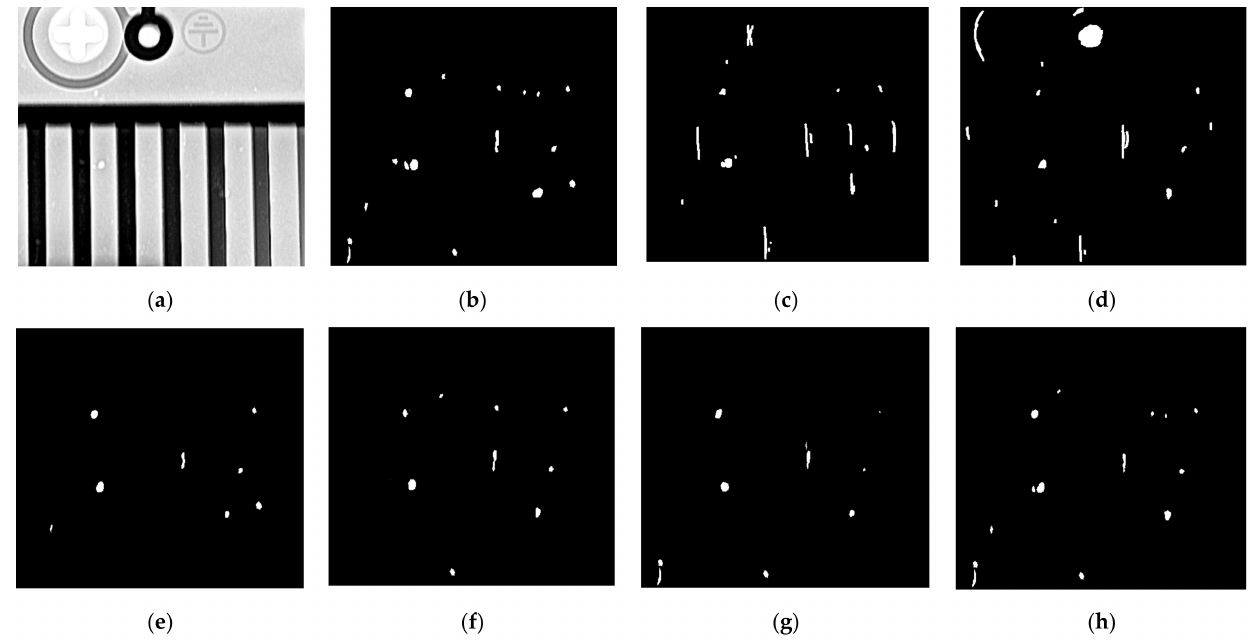
Figure 11. Another example of defect segmentation: ( a ) the original image, ( b ) ground-truth image, ( c ) result of median and morphological filters, Reference [3], ( d ) result of a traditional defect detection algorithm, Reference [4], ( e ) result of Mask R-CNN, ( f ) result of UNet, ( g ) result of standard UNet++, ( h ) result of proposed